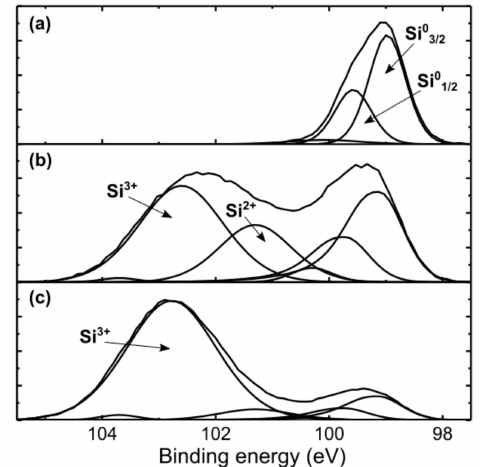
Figure 2. High-resolution XPS spectrum of Si-2p peak measured for ( a ) as-deposited a-Si:Al, ( b ) nanoporous a-Si (one-week exposure to air) and ( c ) nanoporous a-Si:Al (34-week exposure to